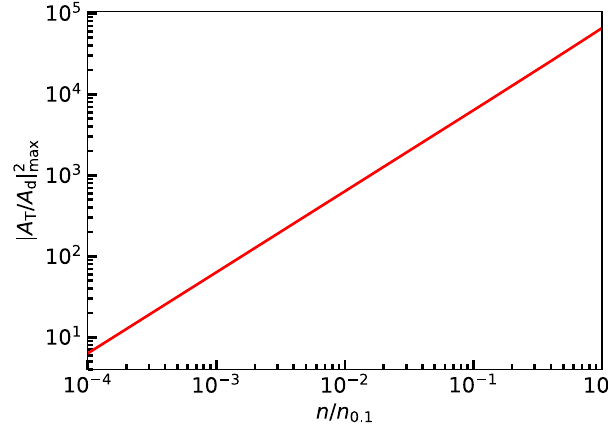
FIG. 4. Terahertz amplification gain versus the initial electron beam densities lower than the critical density for terahertz ¼ 30 THz. Other parameters are the same as in frequency f T